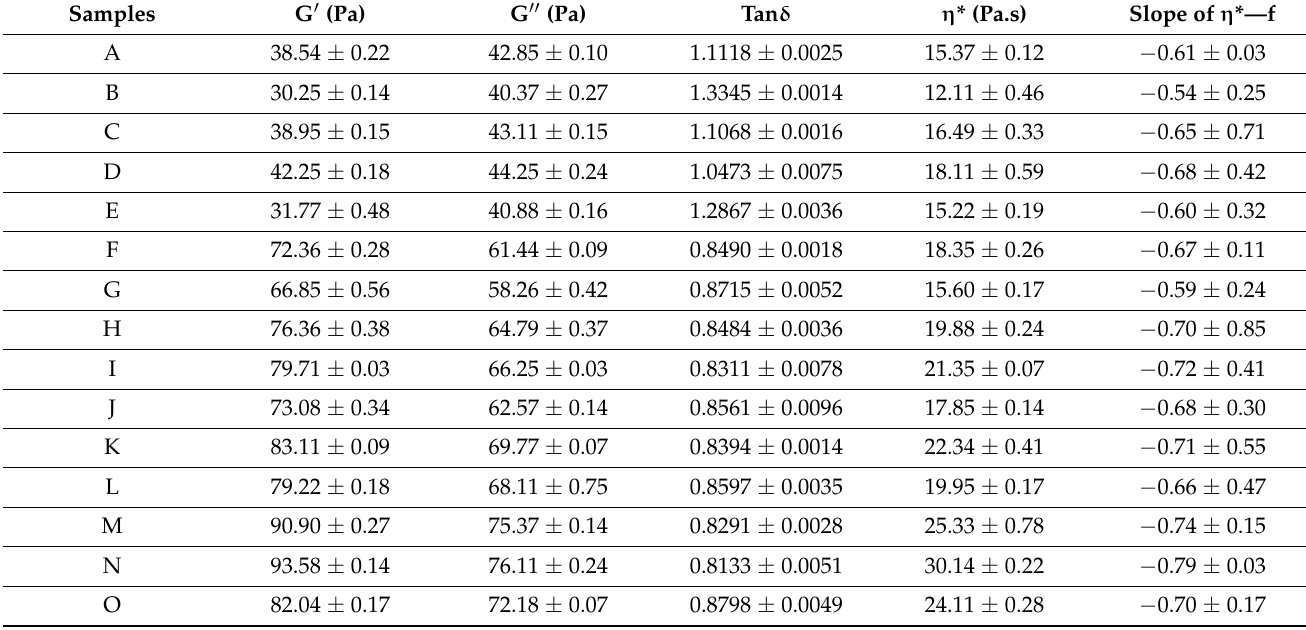
Table 6. Stability of produced emulsions.